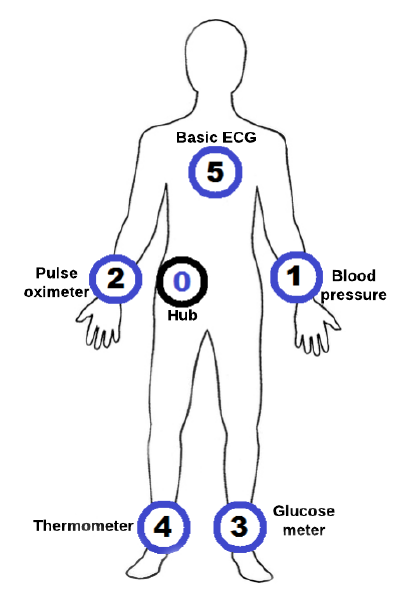
Figure 8. Network topology used in remote monitoring